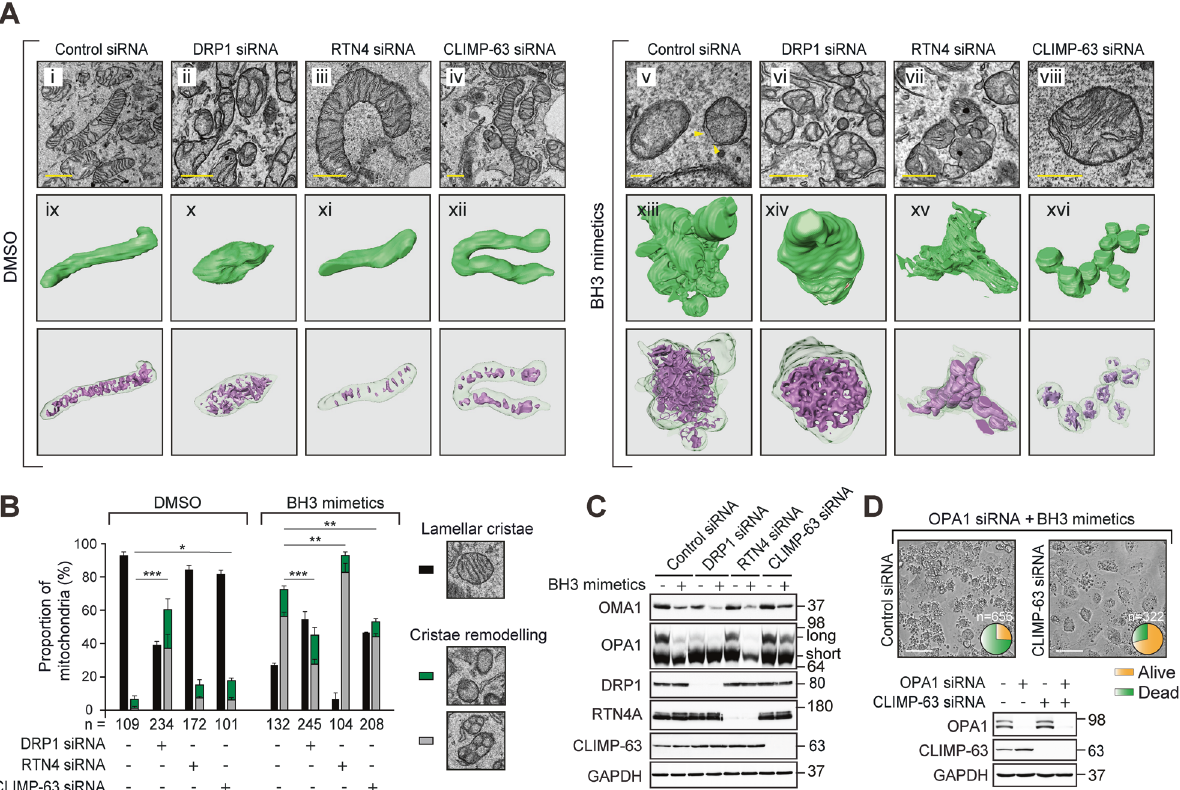
Fig. 8 ER shaping proteins differentially regulate OPA1 proteolysis and mitochondrial cristae remodelling. A TEM images in H1299 cells transfected with the indicated siRNA and treated with a combination of BH3 mimetics, A-1331852 (0.1 μ M) and A-1210477 (10 μ M), and the corresponding renderings of isolated mitochondria (green) and cristae (purple). Scale bars are 500 nm. B The extent of cristae remodelling from A was quanti fi ed in the indicated numbers of mitochondria ( n ) across 3 independent experiments. The histograms are colour-coded to depict the extent of mitochondria possessing lamellar cristae (black), balloon-like cristae (grey) or no cristae (green), and data are presented as mean ± SEM. * p ⩽ 0.05, ** p ⩽ 0.005, *** p ⩽ 0.001 (ordinary one-way ANOVAs with Dunnett ’ s multiple comparisons tests, for remodelled cristae only; DMSO F(38) = 118.0, p < 0.0001; BH3 F(38) = 49.0, p < 0.0001). C Whole cell lysates of H1299 cells, transfected with the indicated siRNA for 72 h, and exposed to Z-VAD.fmk (30 μ M) for 0.5 h, followed by a combination of BH3 mimetics, A-1331852 (0.1 μ M) and A-1210477 (10 μ M) for 4 h, were immunoblotted against the indicated antibodies. D H1299 cells, transfected with siRNAs against OPA1 and/or CLIMP-63 for 72 h, were exposed to a combination of BH3 mimetics, A-1331852 (0.1 μ M) and A-1210477 (10 μ M) for 4 h. Bright fi eld images show live versus dead cells, which were counted in the speci fi ed numbers of cells ( n ) across 3 independent experiments and are presented as pie charts here, and as bar graphs in Supplementary Fig. 13. Western blots reveal knockdown ef fi ciencies of the siRNAs